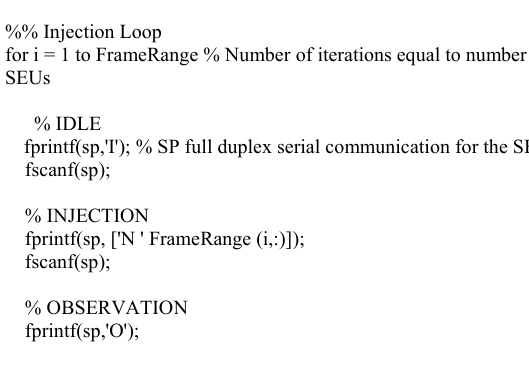
Figure 26. Example of fault injection loop in MatLab.